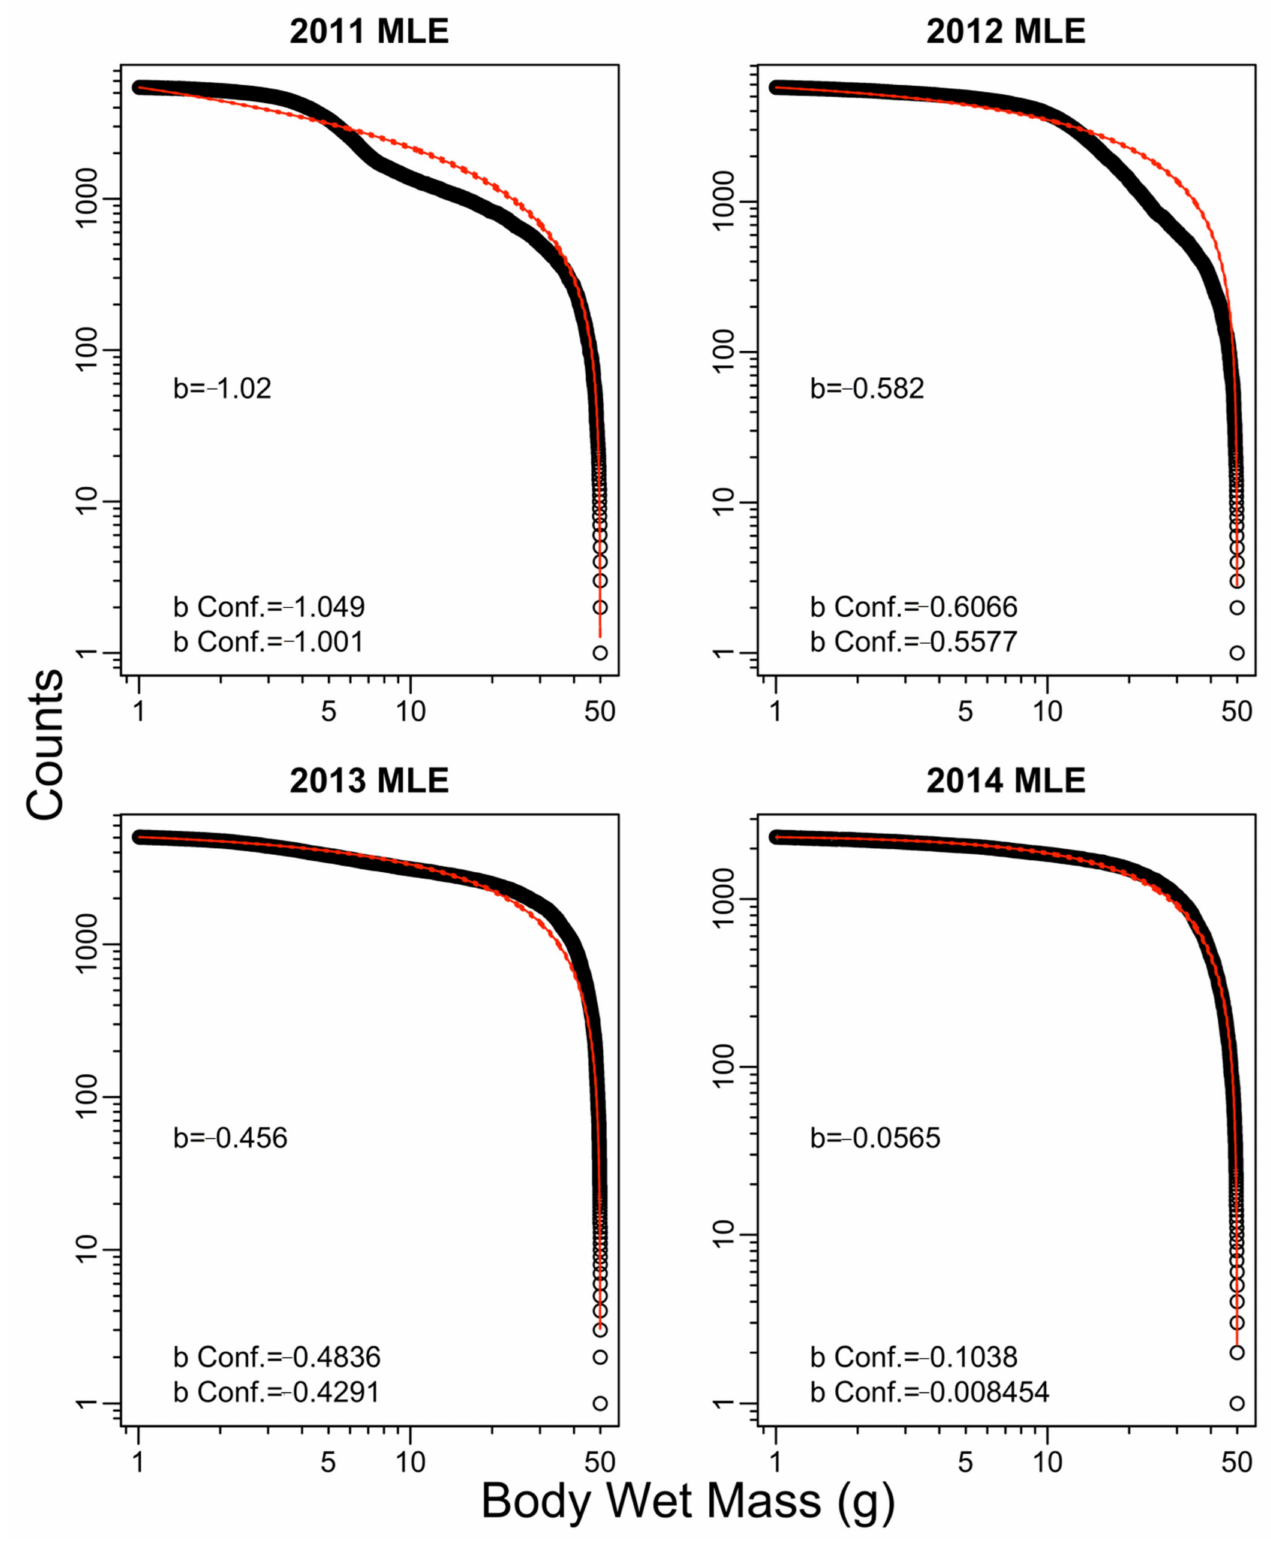
Figure A8. Fish SS with counts and body wet mass (g) fitted using the maximum likelihood estimate of exponent b with the 95% confidence interval of b based on track echo group (TEG) detection from hydroacoustic surveys for